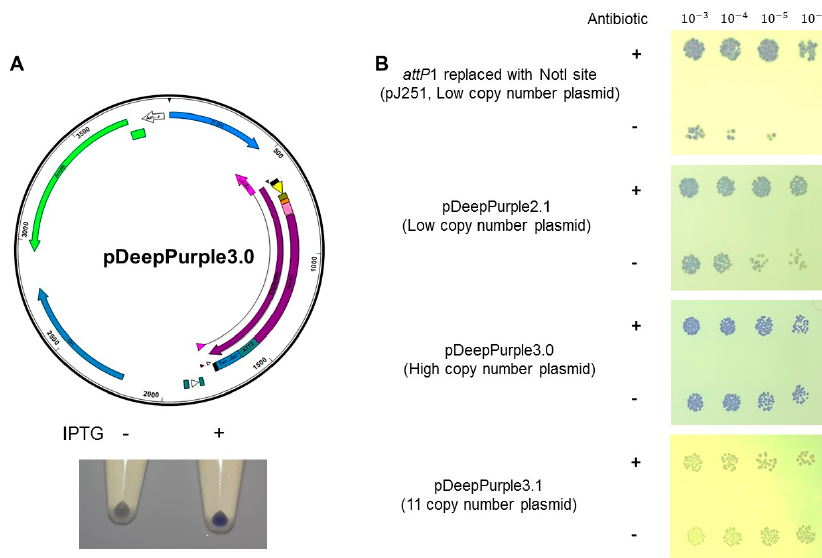
Figure 5. Cloning of the expression cassette to the pTZ19R backbone rendered pDeepPurple3.0. Panel ( A ), plasmid map. Below the map, IPTG induction comparison of AmilCP protein using 0.5 mM in the media for 2 h, ( − ) indicates cells grown under the same conditions but in the absence of IPTG and (+) indicates induction with IPTG. Panel ( B ) Stability test of the cloning plasmid set. Cells were analyzed as described in Materials and Methods after grown 24 h in the presence (+) or absence ( − ) of the selection marker (antibiotic). Serial dilutions are indicated on top of the spot analysis. Selection plates contained the selective agent for each plasmid. Here, the intermediate plasmid bearing only the NotI is shown, blue-purple color is present, and no toxicity was observed.